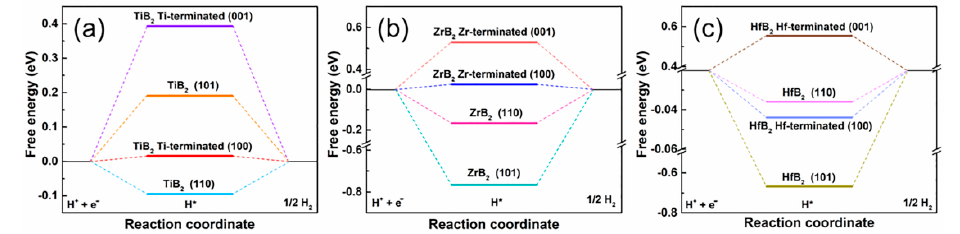
Figure 4. The calculated free-energy diagram (at 25% hydrogen coverage) for HER over different surfaces of ( a ) TiB 2 , ( b ) ZrB 2 , ( c ) HfB 2 .